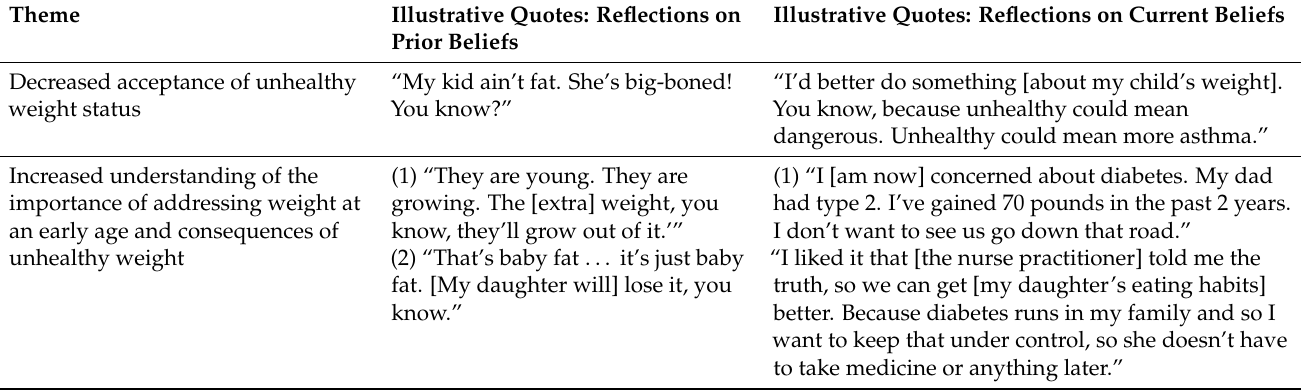
Table 3. Changes in beliefs regarding unhealthy weight and illustrative quotes.